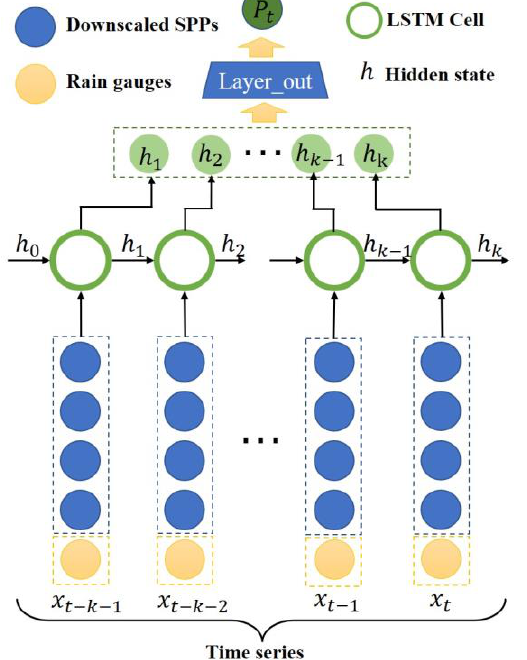
Figure 4. Illustration of the fusion model based on LSTM for merging multisatellite and gauge precipitation.